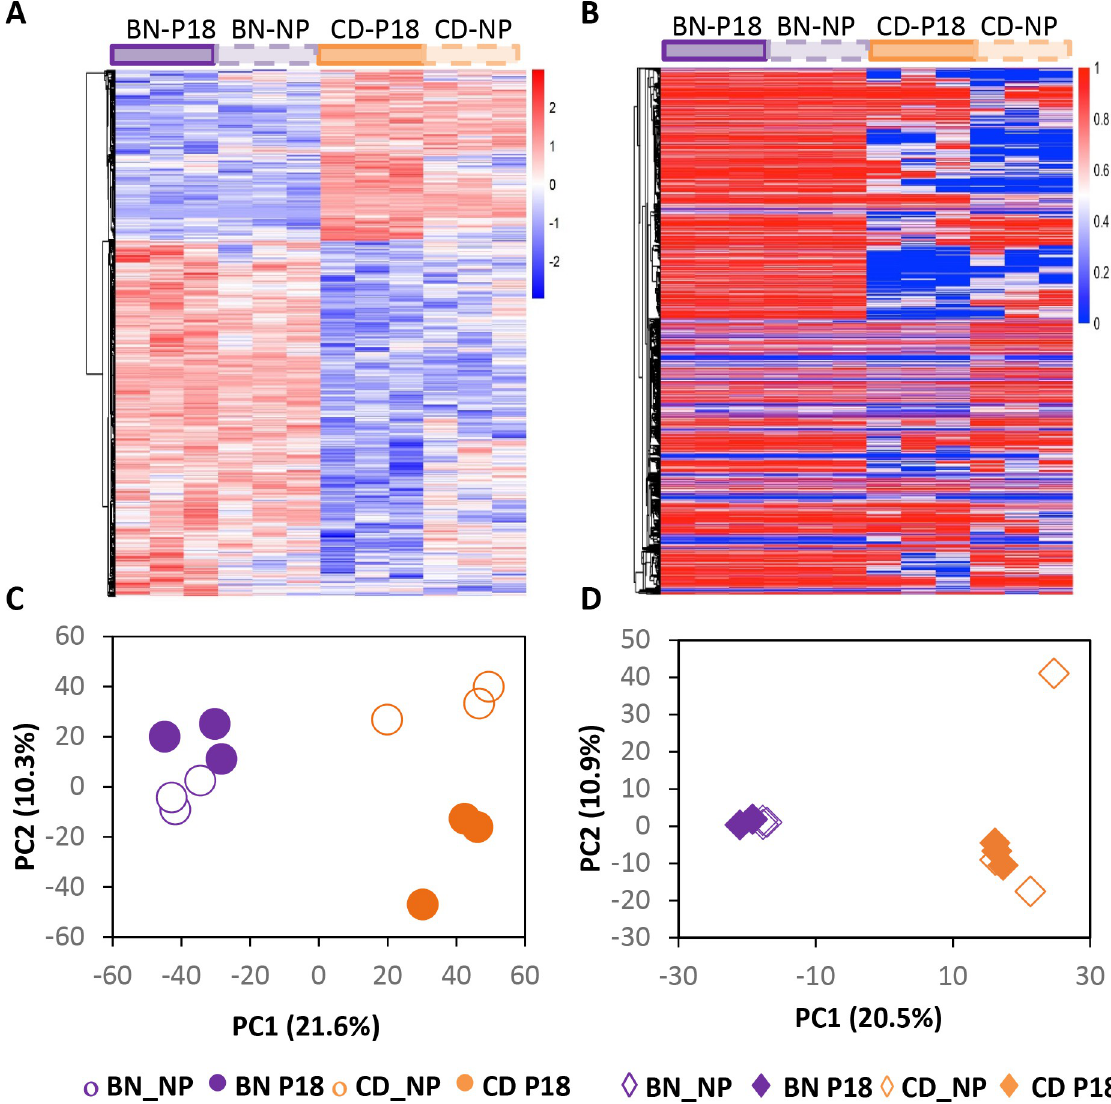
Fig 2. Role of pregnancy and rat strain on renal transcriptomic and methylomic profiles. Heatmap (A) and PCA plot (B) of all DEGs between BN-P and CD-P. Heatmap (C) and PCA plot (D) of all DMRs between the four rat groups. n = 3 for each rat group.